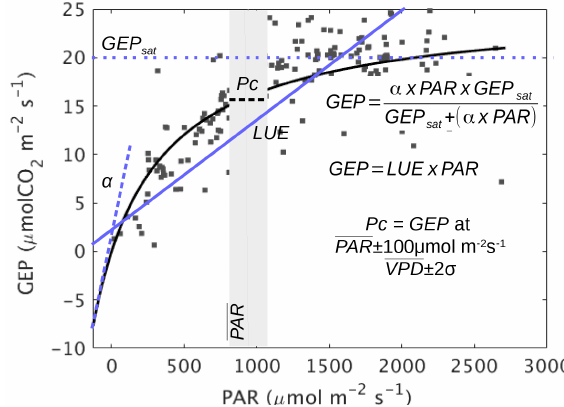
Figure 2. Rectangular hyperbola fitted to 16 days worth of hourly gross ecosystem productivity (GEP, µmolCO 2 m − 2 s − 1 ) vs. pho- tosynthetic active radiation (PAR, µmolm − 2 s − 1 ) data measured at Howard Springs eddy covariance tower (black line). From the rectangular hyperbola: quantum yield ( α , µmolCO 2 µmol − 1 ) (blue dashed line) and GEP at saturation (GEP sat , µmolCO 2 m − 2 s − 1 ) (blue dotted line). Photosynthetic capacity (Pc, µmolCO 2 m − 2 s − 1 ) (black dashed line) was calculated as the 16-day mean GEP at mean annual daytime PAR (PAR) ± 100µmolm − 2 s − 1 (grey area) and mean annual VPD (VPD) ± 2 standard deviations. Light use effi- ciency (LUE, µmolCO 2 µmol − 1 ) was defined as the ratio between daily GEP and PAR, the slope of the linear regression (blue